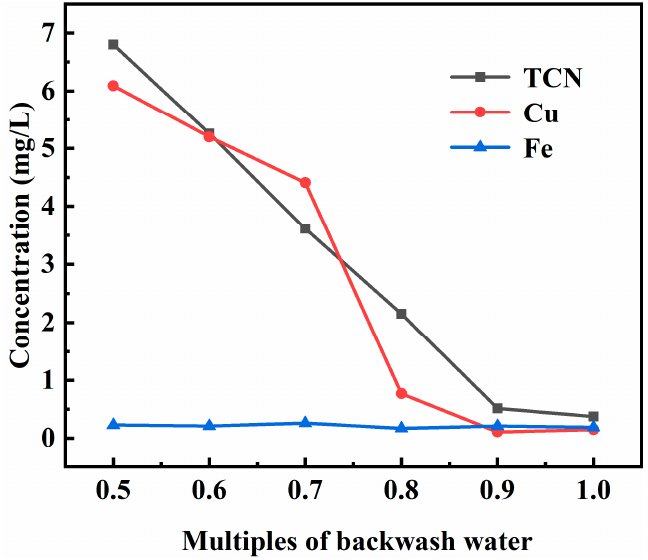
Figure 3. Effect of backwash water multiples on the leaching toxicity of backwashed cyanide tail-